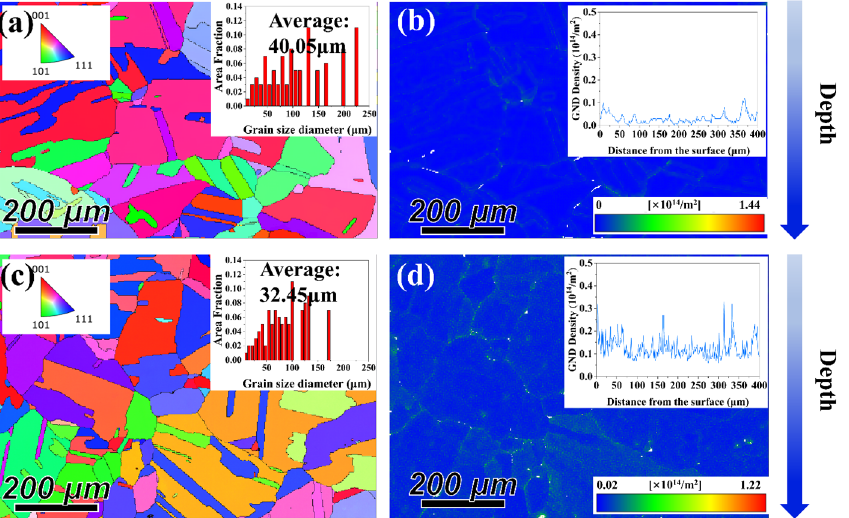
Figure 9. Microstructural characteristics in HAZ on side GH1140 of combustion liner weld with LSP and UN-LSP: ( a ) IPF mapping with UN-LSP, ( b ) GND density mapping with UN-LSP, ( c ) IPF mapping with LSP, and ( d ) GND density mapping with LSP.